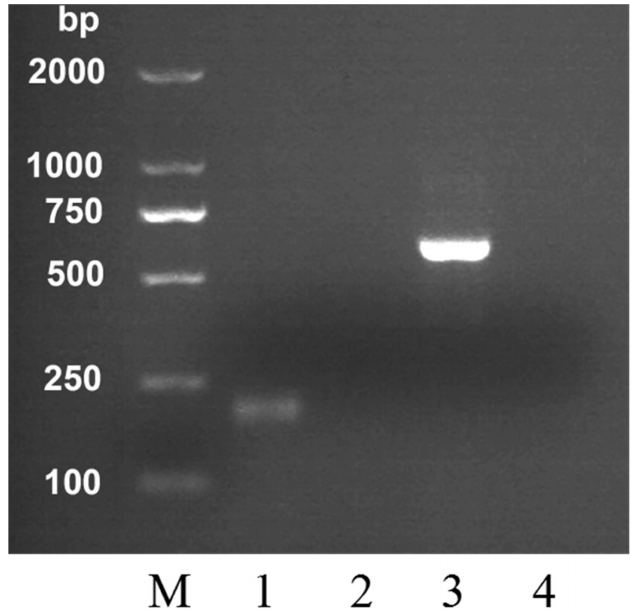
Figure 1. Agarose gel electrophoresis of DNA amplified from genomic DNA extracts of Apis cerana honey and A. mellifera honey in ordinary PCR with the A. cerana honey specific primers (C-F and C-R), and the A. mellifera honey specific primers (M-F and M-R). Lane M, DNA marker; Lane 1, C-F and C-R with A. cerana honey DNA extracts; lane 2, C-F and C-R with A. mellifera honey DNA